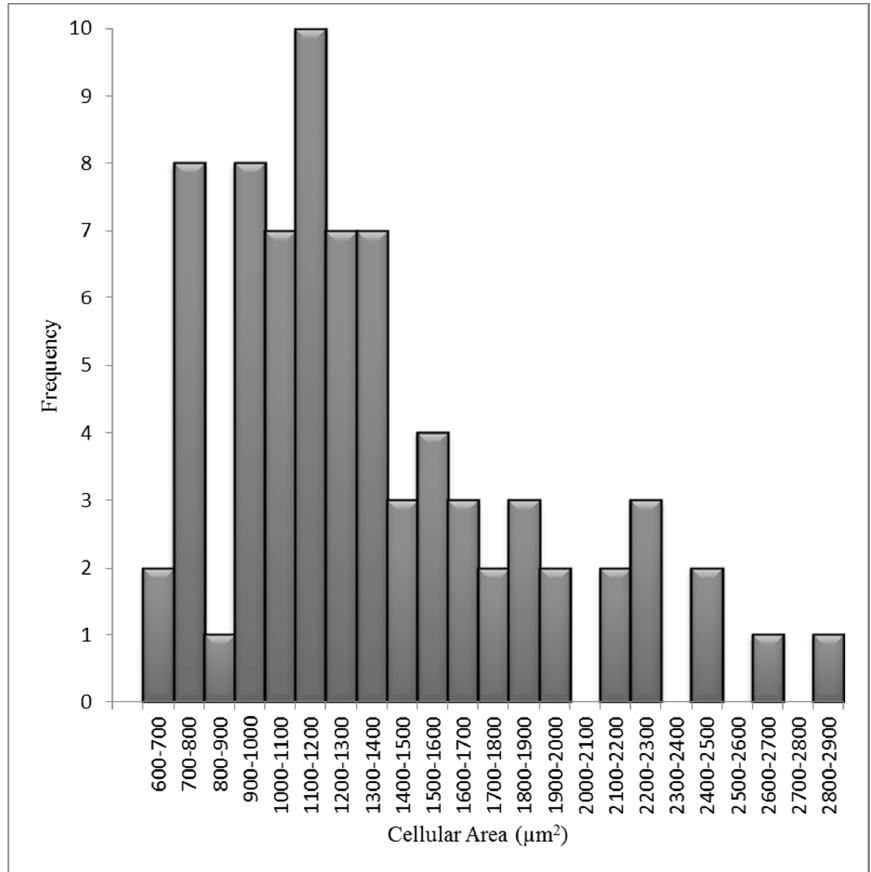
Figure 4. Measured cellular area distributions for the HF19 cell line. The mean cellular area is 1557 µm 2 for 80 cells over three experiments.